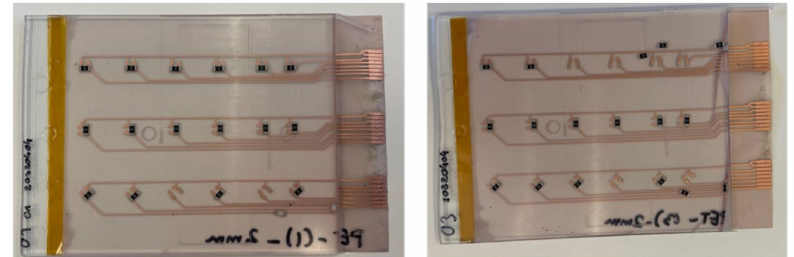
Figure 46. Example of detached components.